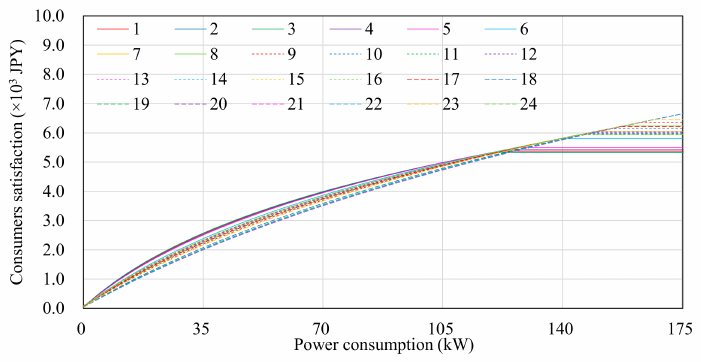
Figure 5. Hourly satisfaction functions in the day of the highest electricity consumption.